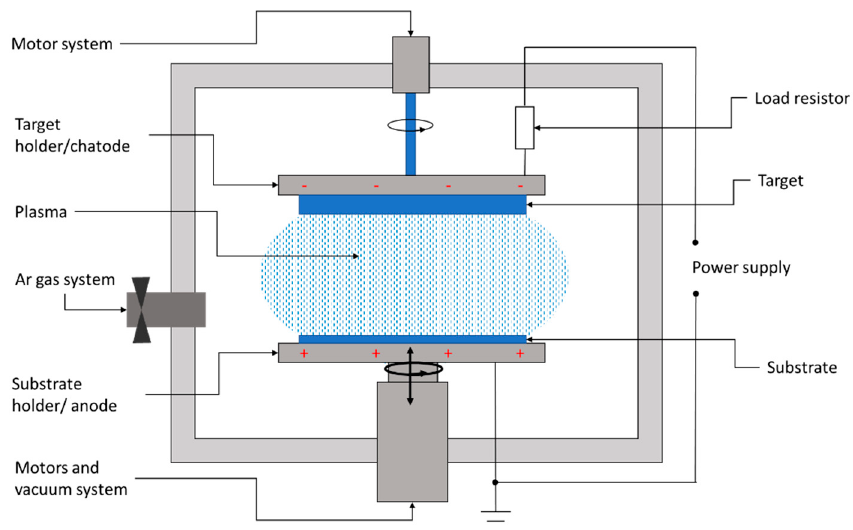
Figure 6. Layout of a DC sputtering system for the deposition of thin films.